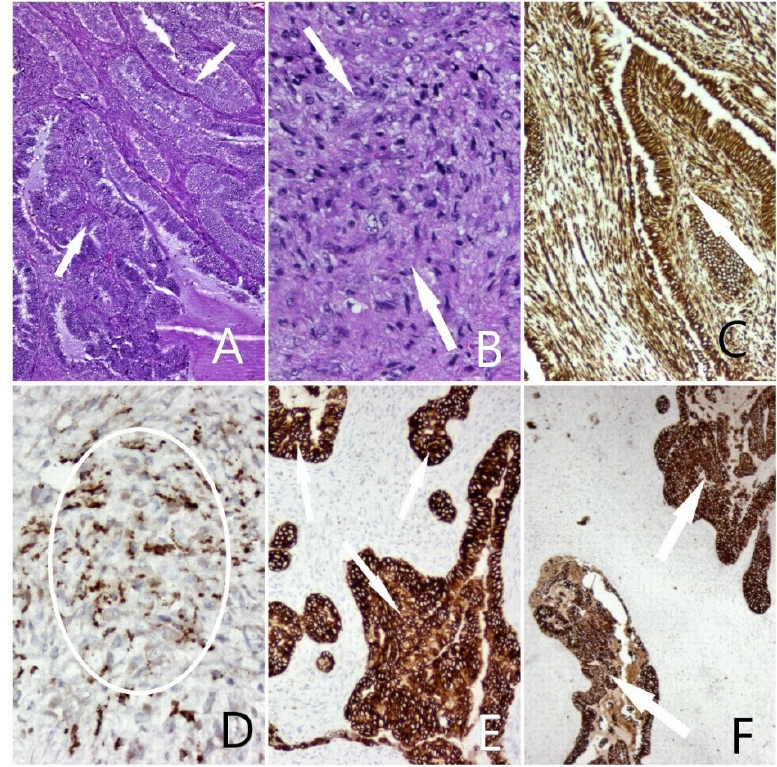
Figure 3. ( A ) Carcinosarcoma, epithelial component: Endometrial adenocarcinoma, atypical glan- dular structures, lined by a columnar epithelium–HE, ob. 5×; ( B ) Carcinosarcoma, mesenchymal component: Storiform proliferation of mesenchymal cells with marked anisocytosis, anisocaryosis, pleomorphism, hyperchromic nuclei–HE, 20×; ( C ) Biphasic tumoral positivity–Vimentin positive staining, ob. 5×; ( D ) Malignant mesenchymal cellular elements–CD68 positive staining, ob. 20×; ( E ) Epithelial malignant component-CTK AE1/AE3 positive staining, ob. 10×; ( F ) Epithelial malignant component–CK7 positive staining, ob. 10× (Lesions indicated by arrows).